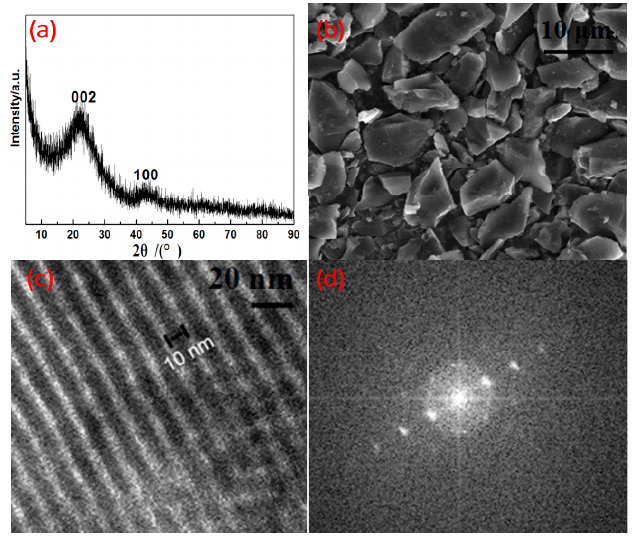
Figure 3. Electrochemical properties: ( a ) =XRD spectrum of the synthesized OMC; ( b ) SEM photograph of the OMC; ( c ) and ( d ) =TEM photographs of the OMC.